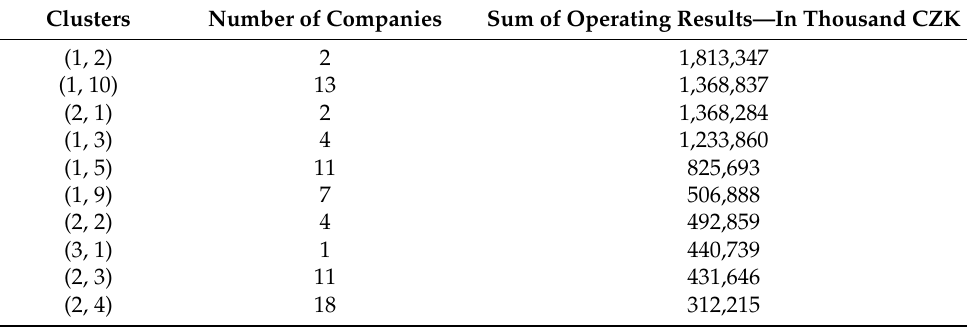
Table 22. Table of ten clusters with the highest sum of OR for the year 2016.